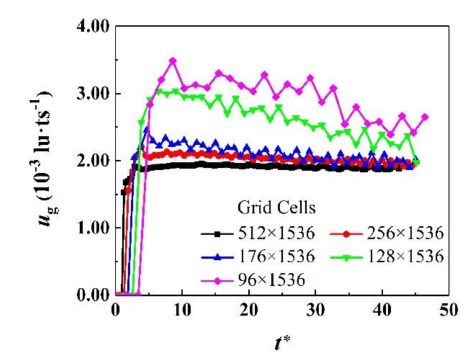
Figure 5. Variations of the bubble rising velocity with dimensionless time using five di ff erent